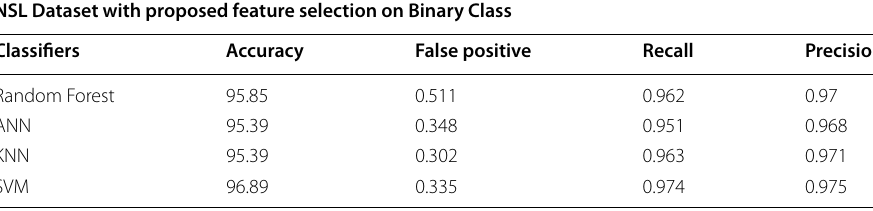
Table 14 Results of applying proposed feature selection method on NSL dataset NSL Dataset with proposed feature selection on Binary Class